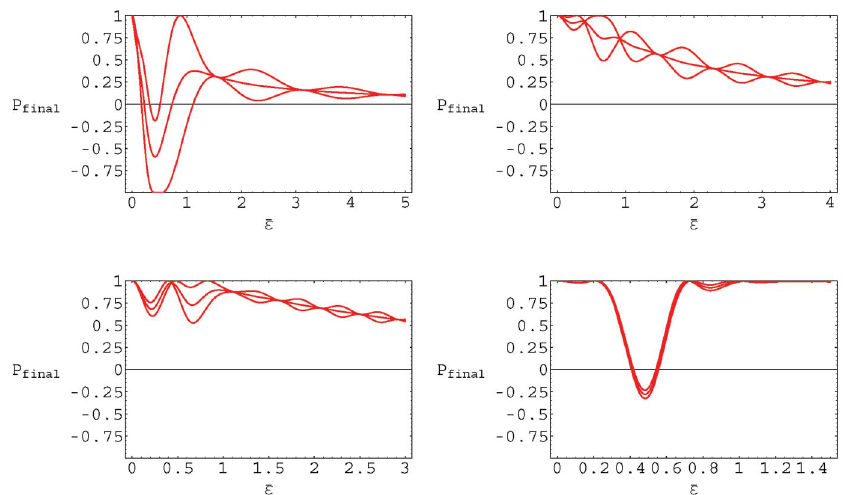
FIG. 8. (Color) Final polarization after twice crossing a resonance in a sloped-step pattern as function of (cid:5) (cid:3) for four different values of (cid:5) A . Red curves give the mean, upper bound, and lower bound of the oscillating final